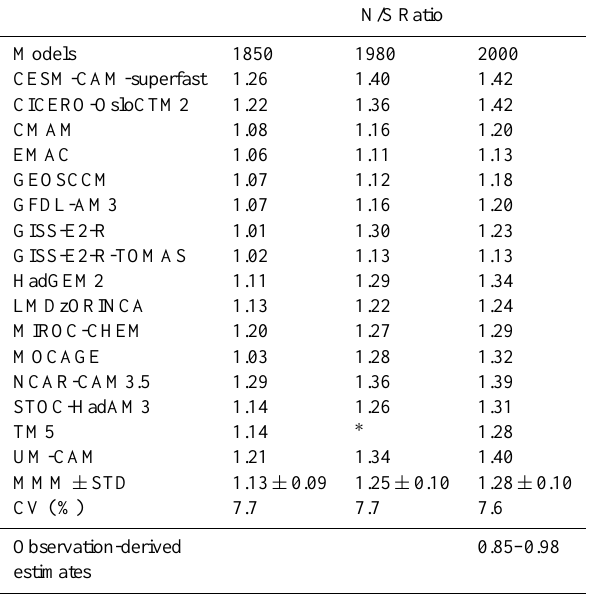
Table 2. Inter-hemispheric ratio (N/S) of tropospheric mean OH from models for 1850, 1980 and 2000 time-slices. Observation- derived estimates shown in the last row are based on Montzka et al. (2001), Prinn et al. (2001), Krol and Lelieveld (2003), and Bous- quet et al. (2005). A cell with ∗ means that the model did not report that